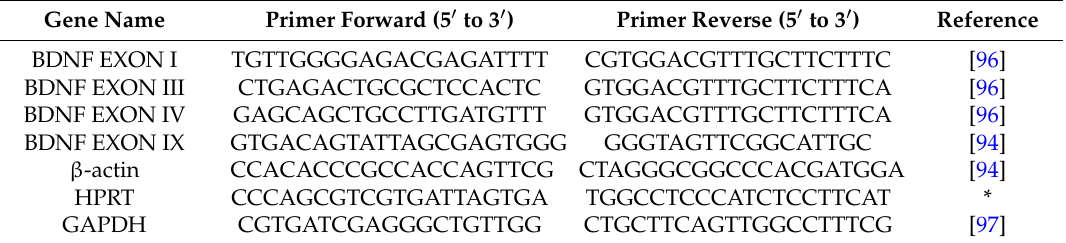
Table 3. Primer sequences used for real-time PCR to amplify genes of